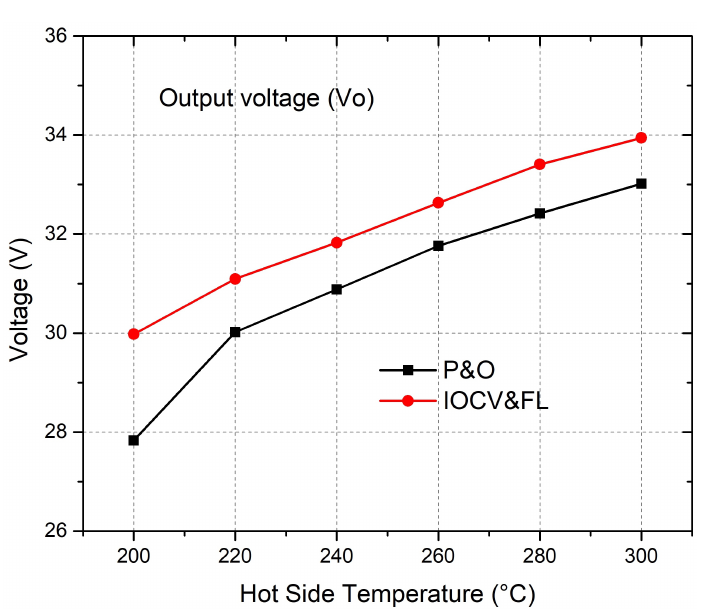
Figure 12. Duty cycle plot.